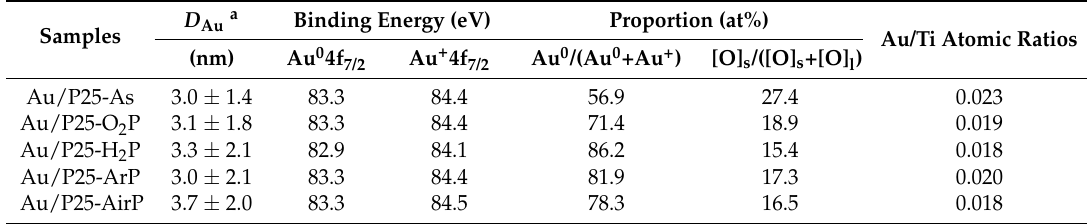
Table 2. Gold nanoparticles diameter and XPS data of the Au/P25 catalysts.